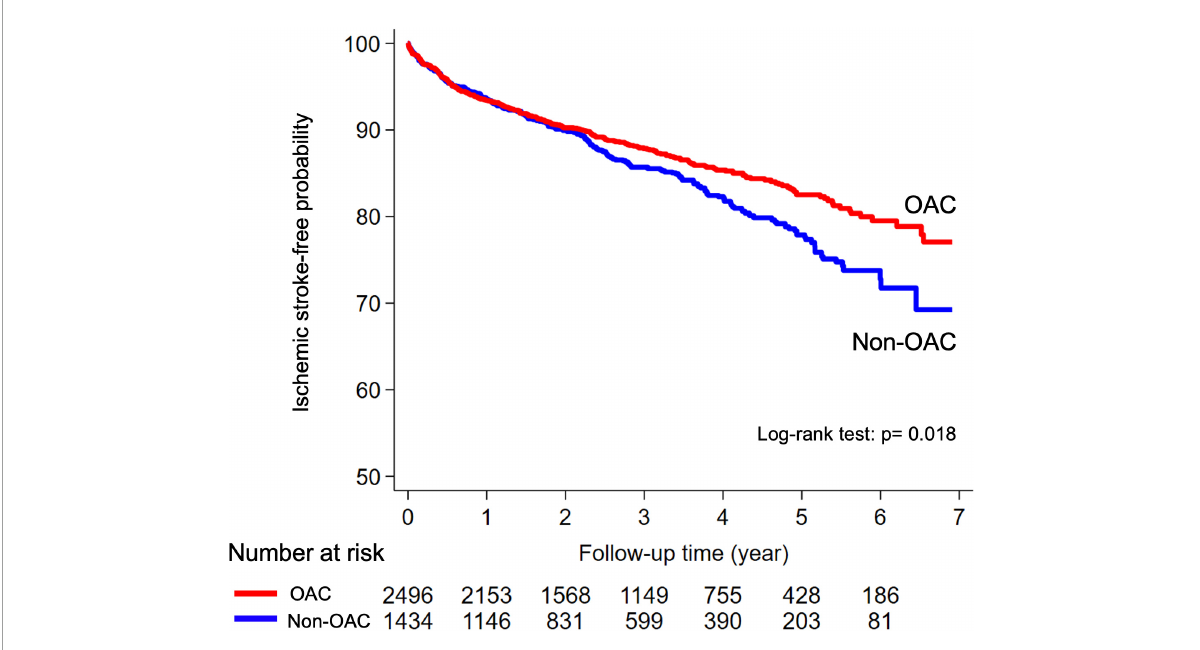
FIGURE2 Kaplan–Meier curves for ischemic stroke event-free probability in the OAC and non-OAC cohorts among patients with AFDAS. AFDAS, atrial fibrillation detected after stroke; OAC, oral anticoagulant.